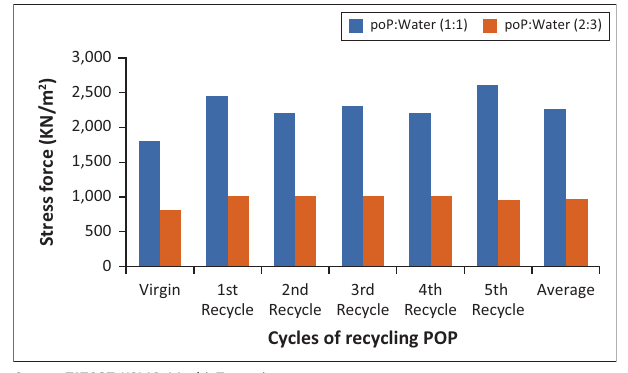
FIGURE 15: Compressive